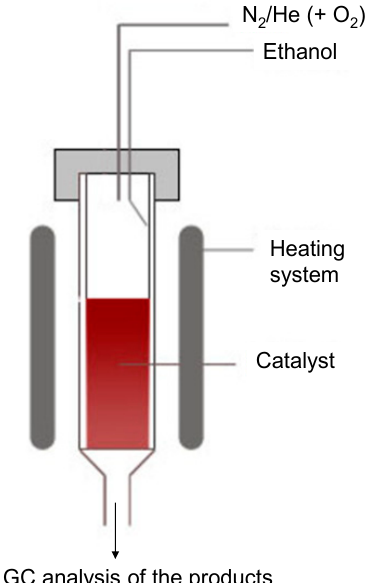
Figure 5. Vertical glass reactor.